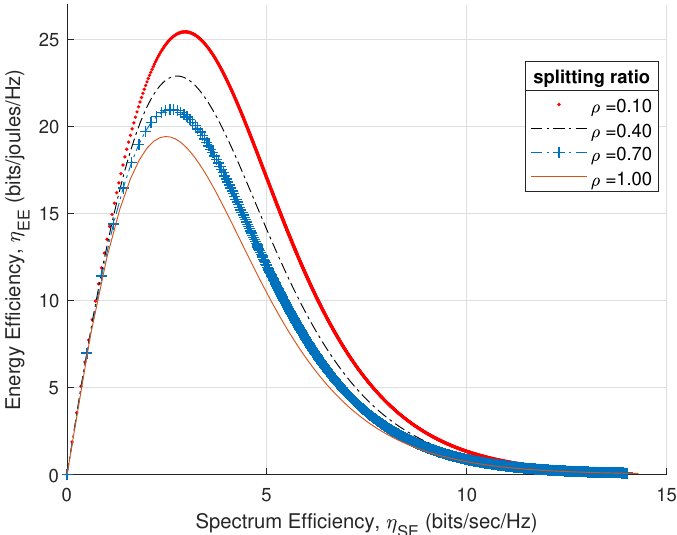
Figure 4. Spectral efficiency (SE) vs. energy efficiency (EE) trade-off in PS